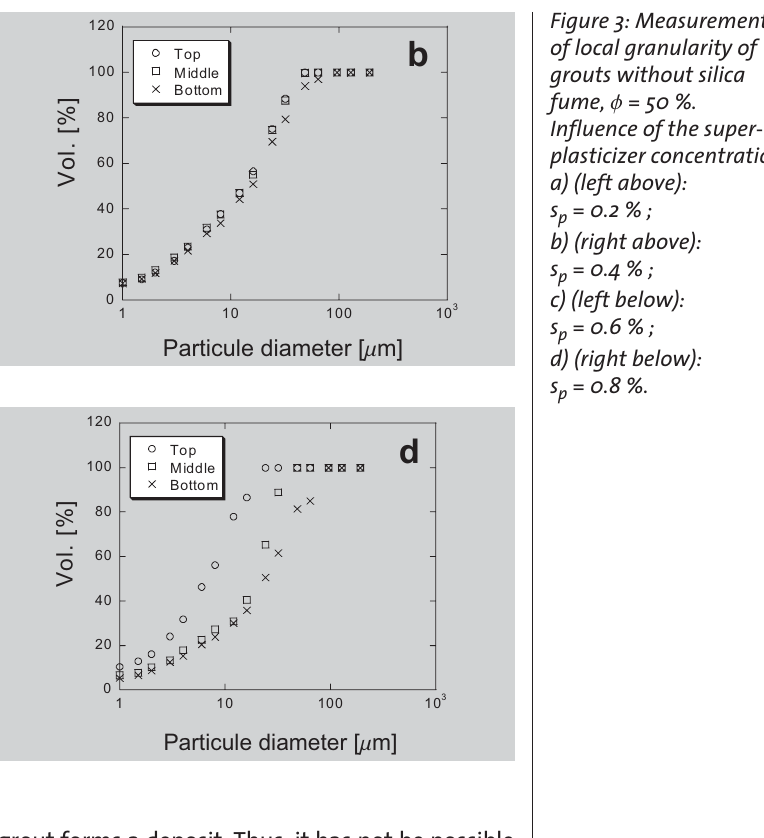
Local granularity